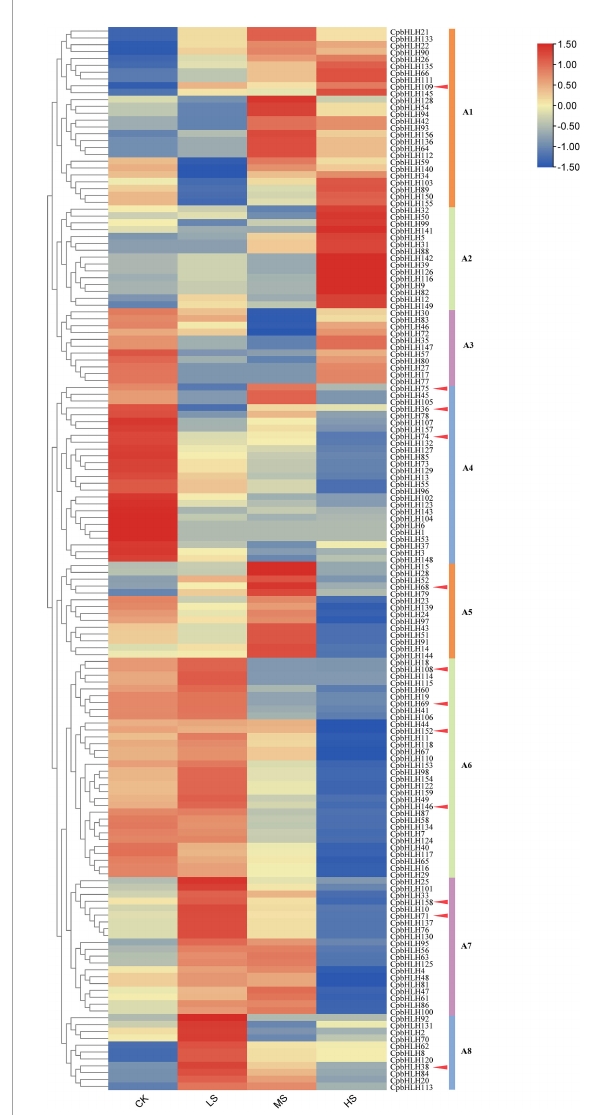
FIGURE 8 Clustering expression analysis of 159 CpbHLH genes in salt stress based on hydroponic experiments. The CK, LS, MS and HS represent the NaCl concentrations of 0%, 0.15%, 0.3% and 0.45% respectively. The transcript abundance level was normalized and hierarchically clustered by using the log 2 (FPKM + 1) comparison among genes of different treatments. The expression value is presented on the color scale, with red representing high expression and blue representing low expression. A1-A8 represent different clusters. In order to distinguish A1-A8 clusters more intuitively, lines of different colours were used in the